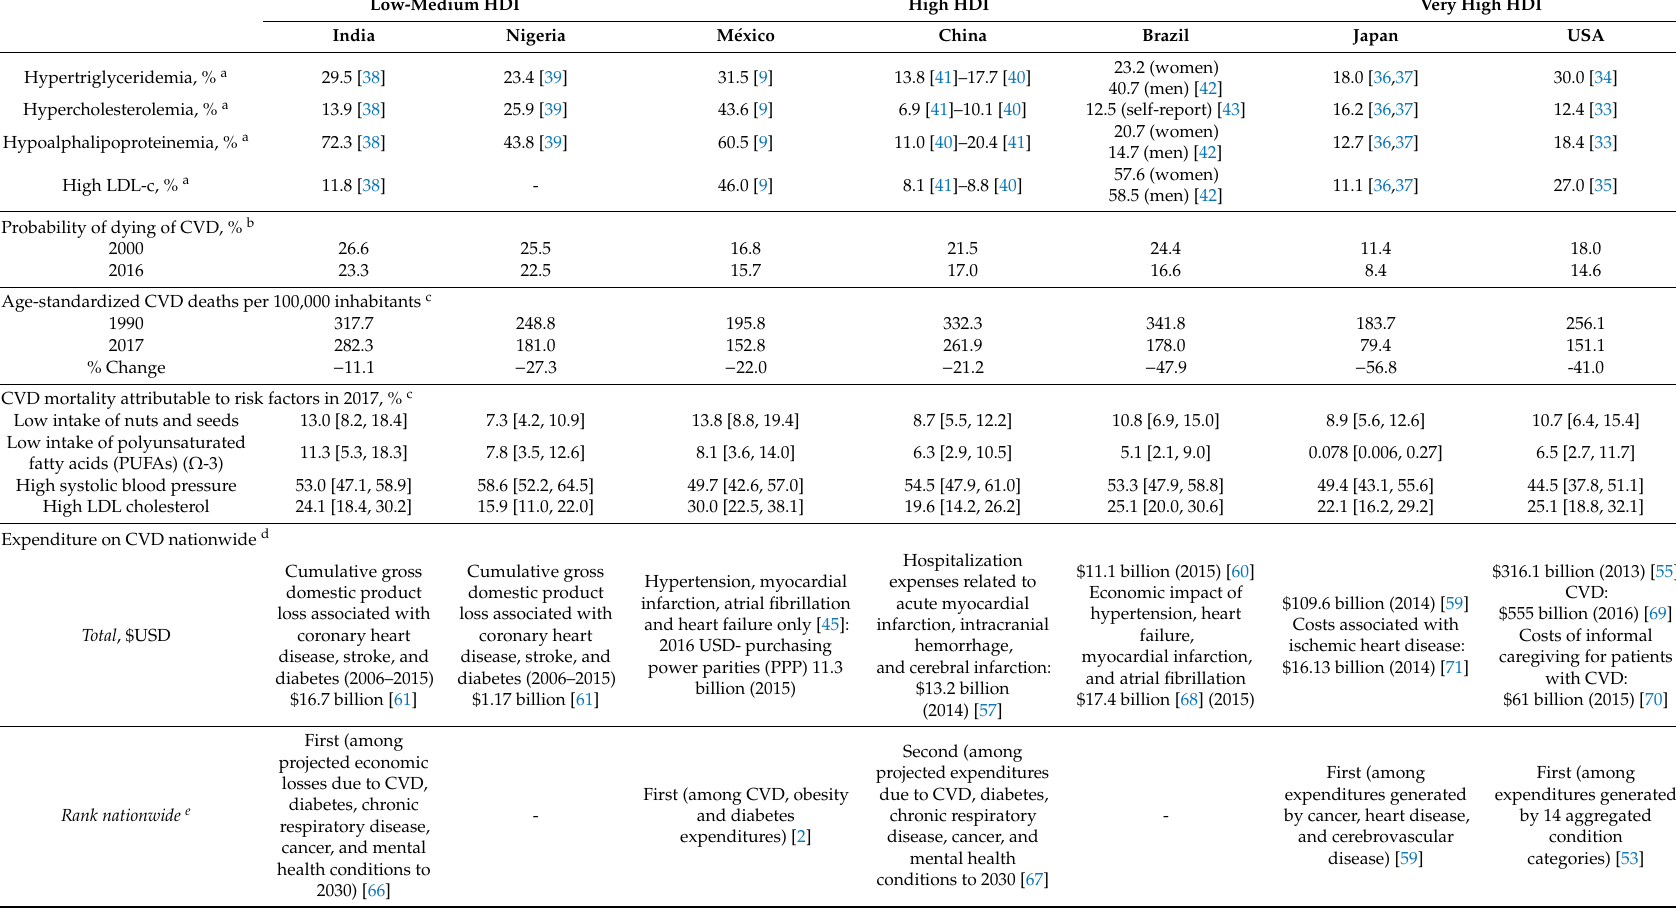
Table 2. Epidemiological and economic scenario related to CVD in seven